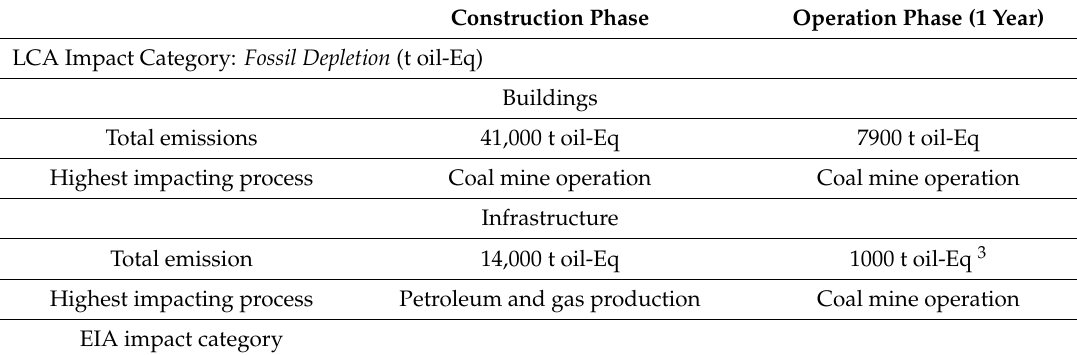
Table 6. On-site and o ff -site impact of DP1 on